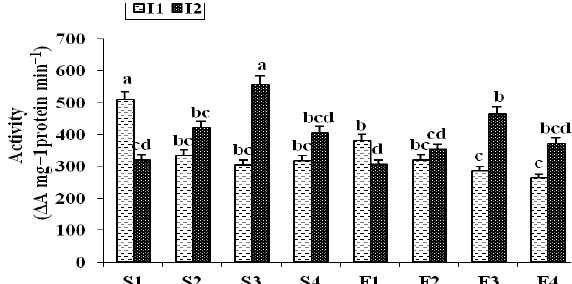
Fig. 6. Changes in protein content due to water deficit stress and application of Fe; I1- normal irrigation or irrigation to reach 50% soil moisture depletion of field capacity, I2- irrigation from the beginning of flowering to the end of pollination stage reaching 75% of soil moisture depletion of field capacity; S- soil application of Fe, S1- without soil application of Fe; S2- 50 Fe Kg ha -1 , S3- 100 Fe Kg ha -1 , S4- 150 Fe Kg ha -1 ; F- foliar application of Fe, F1- foliar application of water, F2- 1,000 Fe mg l -1 , F3- 2,000 Fe mg l -1 , F4- 3,000 Fe mg l -1 ; LS MEANS within each column of each section followed by the same letter are not significantly different (p ≤ 0.05) soluble proteins content in I1